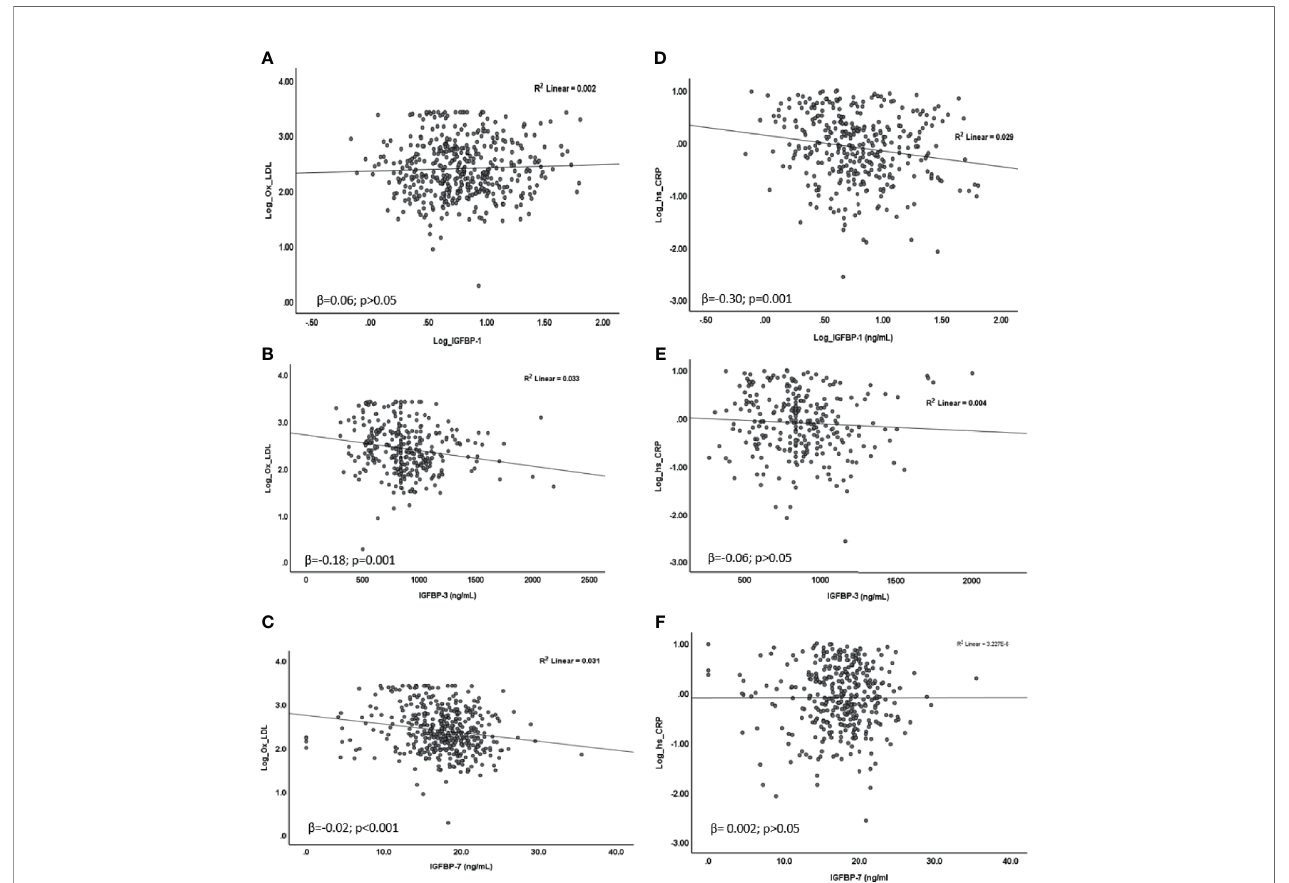
FIGURE 2 | Association of Ox-LDL (A – C) and Hs-CRP (D – F) with IGFBPs. (A) Ox-LDL was not associated with IGFBP-1 ( b = 0.06; p = 0.40), (B, C) Ox-LDL was negatively associated with IGFBP-3 ( b = -0.18; p = 0.001) and IGFBP-7 ( b = -0.02; p < 0.001). (D) Hs-CRP was negatively associated with IGFBP-1 ( b = -0.30; p = 0.001) (E, F) No signi fi cant association of Hs-CRP was found with either IGFBP-3 ( b = -0.06; p > 0.05) or IGFBP-7 ( b = 0.002; p > 0.05). Data were analyzed by linear